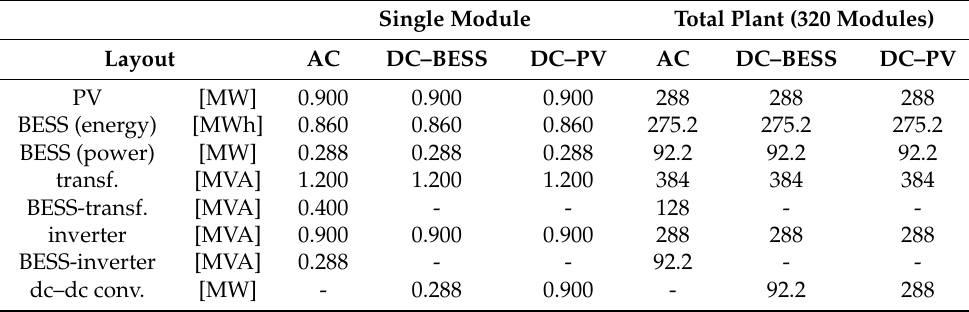
Figure 2. Possible coupling architecture for PV and BESS modules: ( a ) AC-coupling; ( b ) DC-coupling/BESS-side; ( c ) DC- coupling/PV-side. Table 1. Data of the case study of PV+BESS plant components in Figure 2.